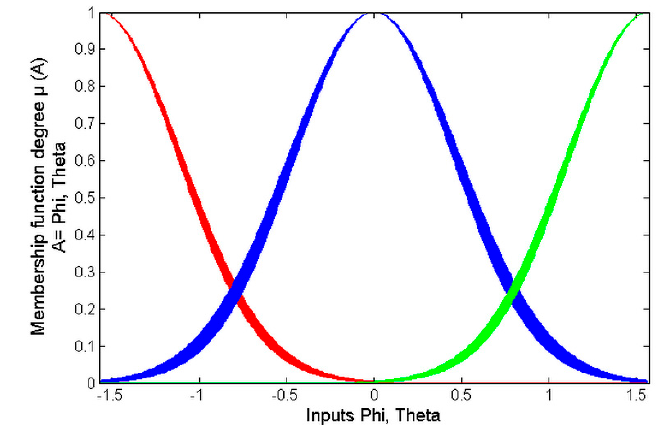
Figure 8. Membership functions of the IT2-AFS ˆ g 1